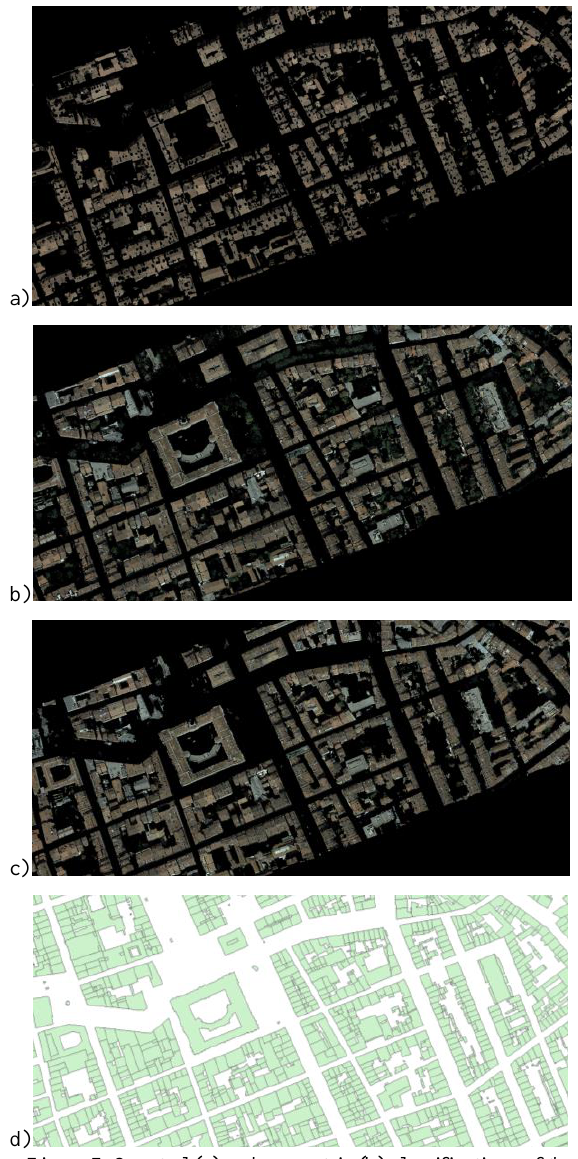
Figure 7: Spectral (a) and geometric (b) classifications of the building class. Results obtained combining both information